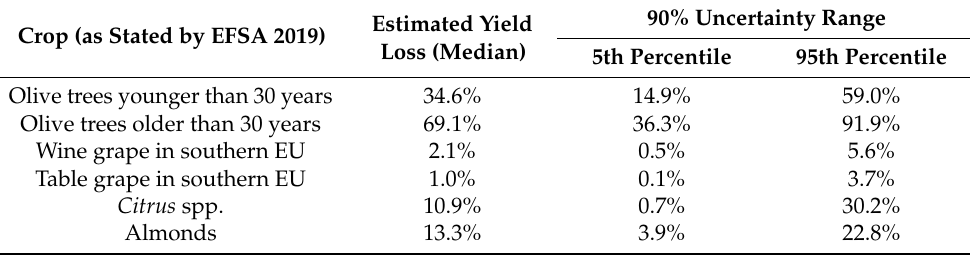
Table A1. Estimated yield losses and uncertainty ranges used for the estimation of potential socio- economic impacts of Xylella fastidiosa for the main crops in the European Mediterranean countries, the Balkans, and the Middle East and North Africa region.